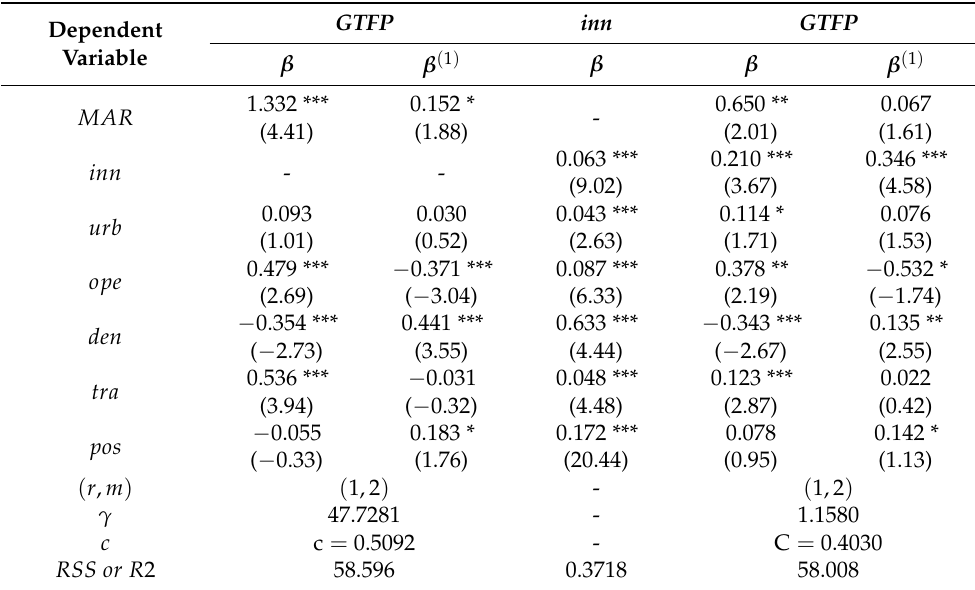
Table 8. The test results of the innovation development effect in market driving